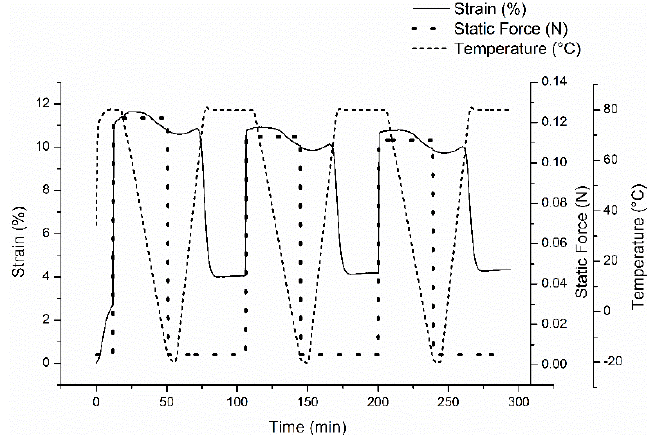
Figure 12. Dynamical mechanical thermal analysis (DMA) shape memory test for sample 5050DSS.